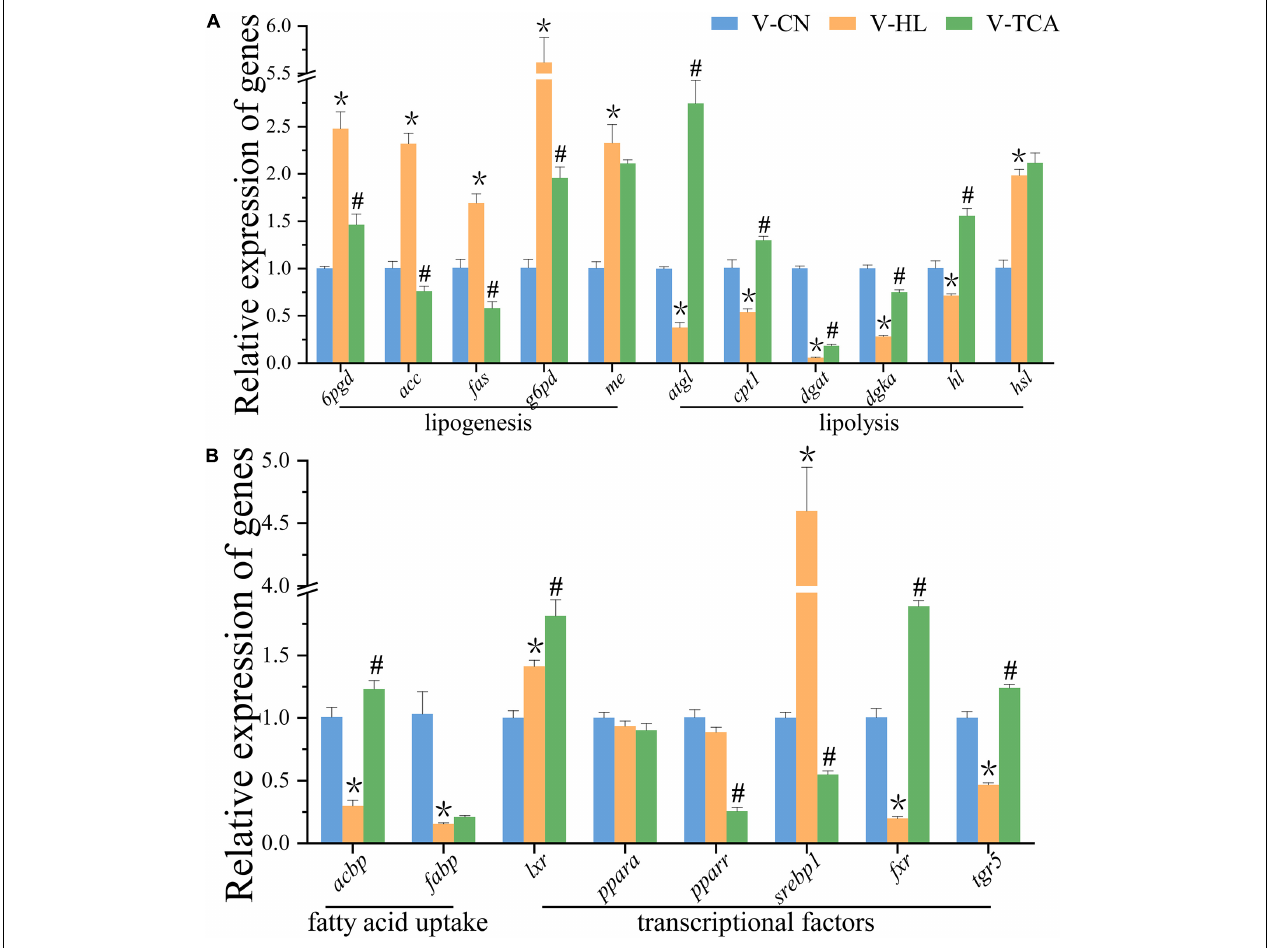
FIGURE 4 | The relative expression of genes associated with lipid metabolism of hepatocytes normalized to 18s and β -actin in lipid emulsion and BAs incubation (A,B) ( n = 9). Values are presented as means with SD, where “*” indicates significant ( p < 0.05) differences in the V-HL group (compared to the V-CN group), and “#” indicates significant ( p < 0.05) differences in the V-TCA group (compared to the V-HL